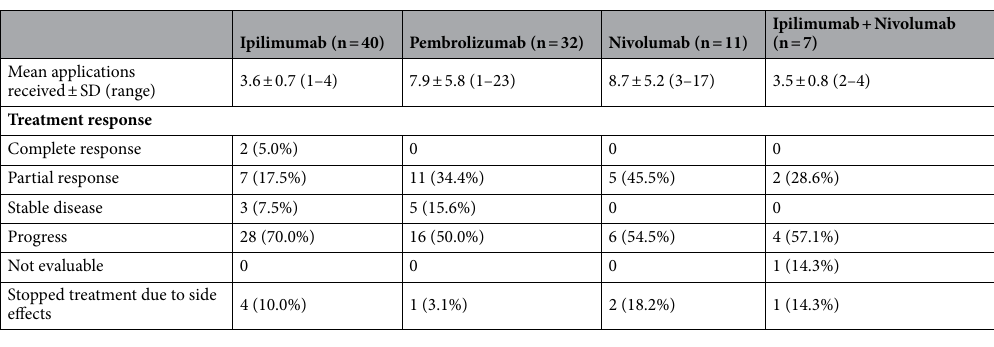
Table 1. CPI treatment